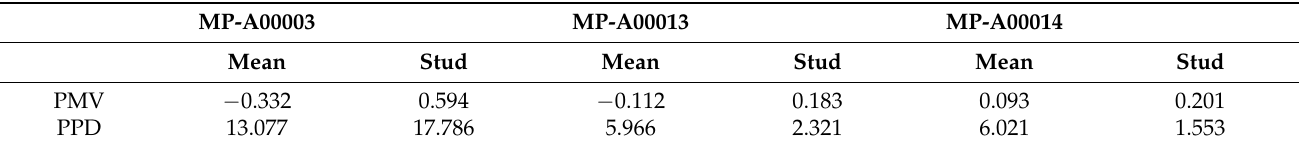
Table 6. Average PMV/PPD values for the three platforms.